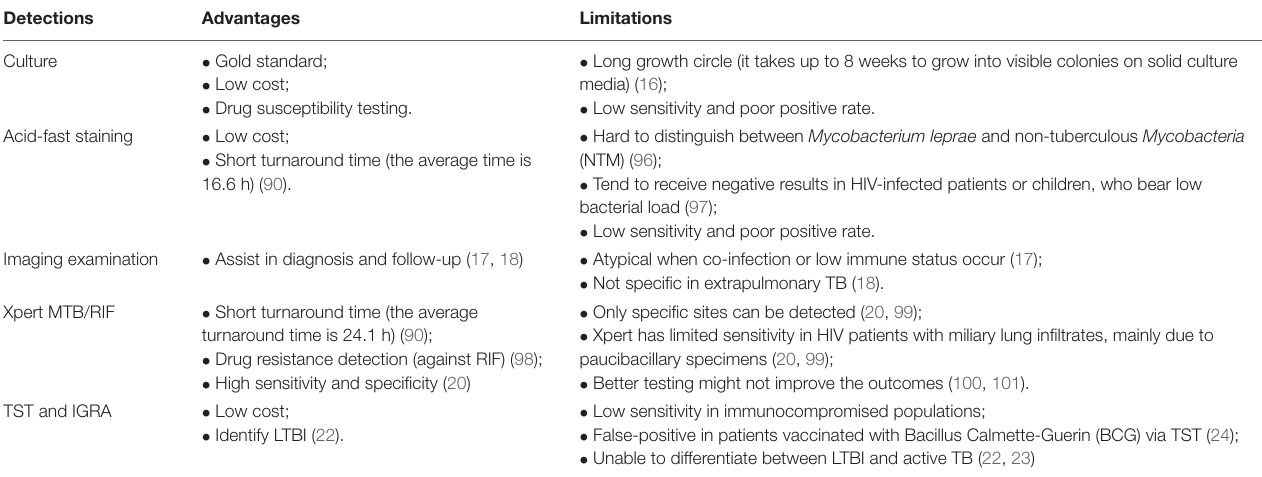
TABLE 1 | Summary of advantages and limitations of routine detections for Mycobacterium tuberculosis